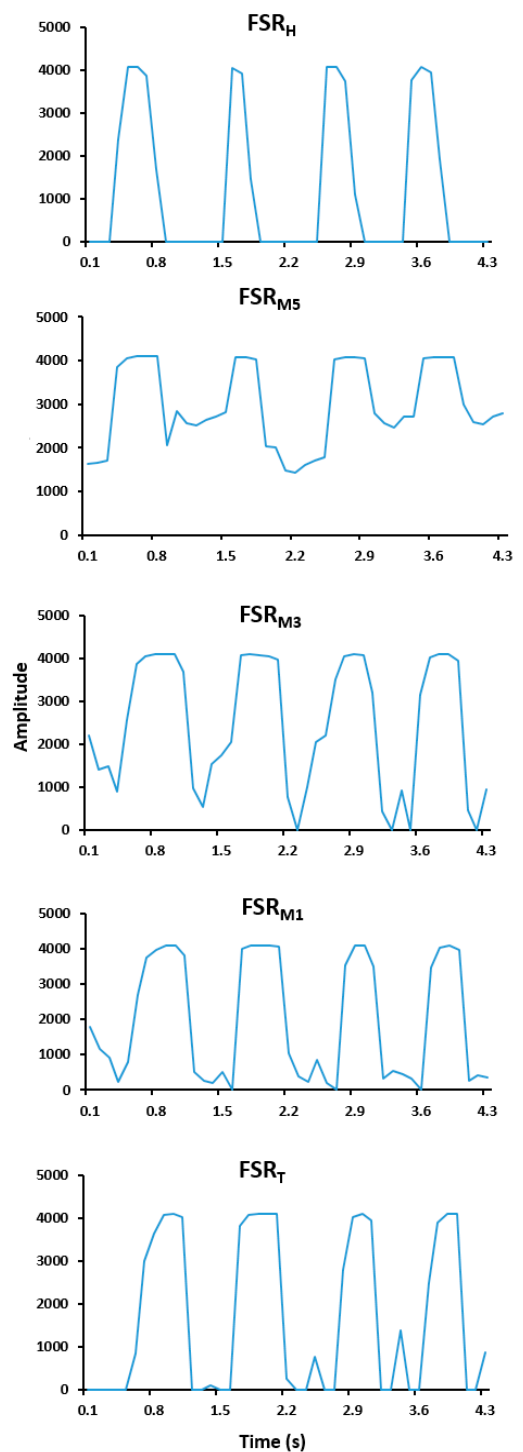
Figure 2. Examples of pressure signals of individual Force Sensitive Resistor (FSR) placed under the heel (FSR H ), the heads of the first (FSR M1 ), third (FSR M3 ) and fifth (FSR M5 ) metatarsal bones (FSR M1 , FSR M3 , FSR M5 , respectively), and the great toe (FSR T ) for one participant.